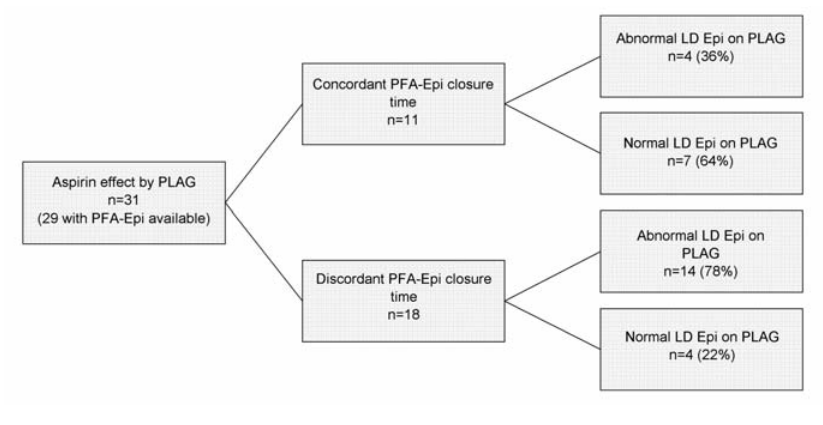
Figure 3. PFA-epinephrine results in patients with thrombosis who show aspirin effect by platelet